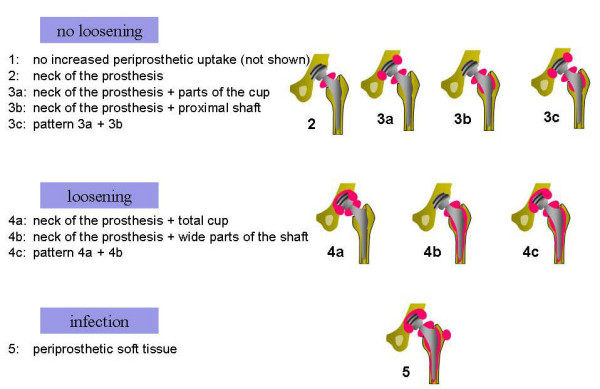
Qualitative visual analysis of tracer distribution according to the classification system of Reinartz et al. [11]